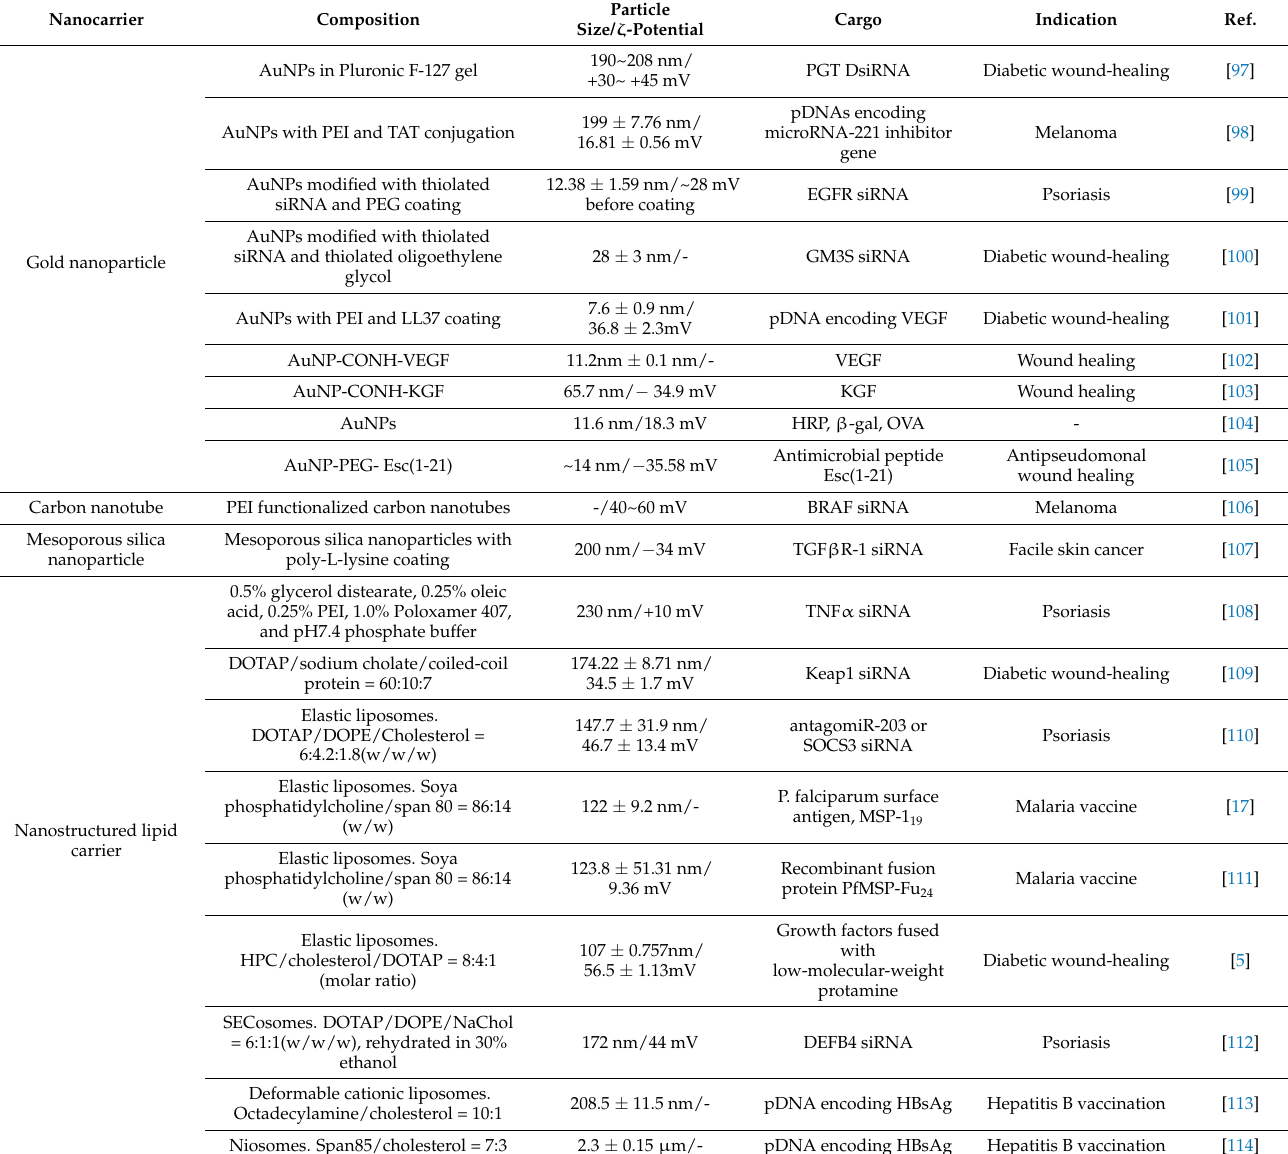
Table 1. Current reports of using nanovesicles for dermal and transdermal delivery of